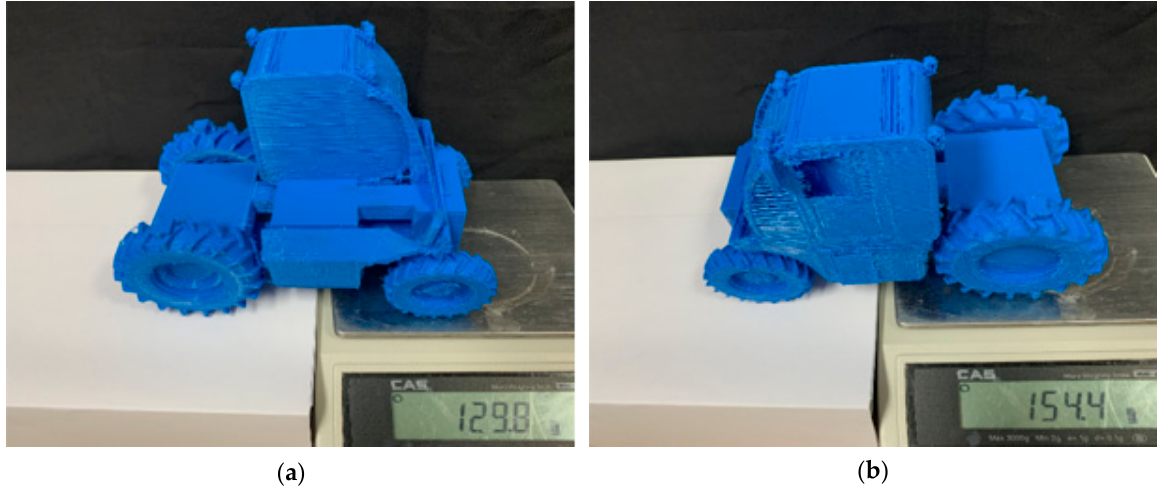
Figure 7. Measurement of axle weight of the miniature tractor: ( a ) Front axle; ( b ) Rear axle. Table 3. Comparison of weight distribution between the original and reduced model.